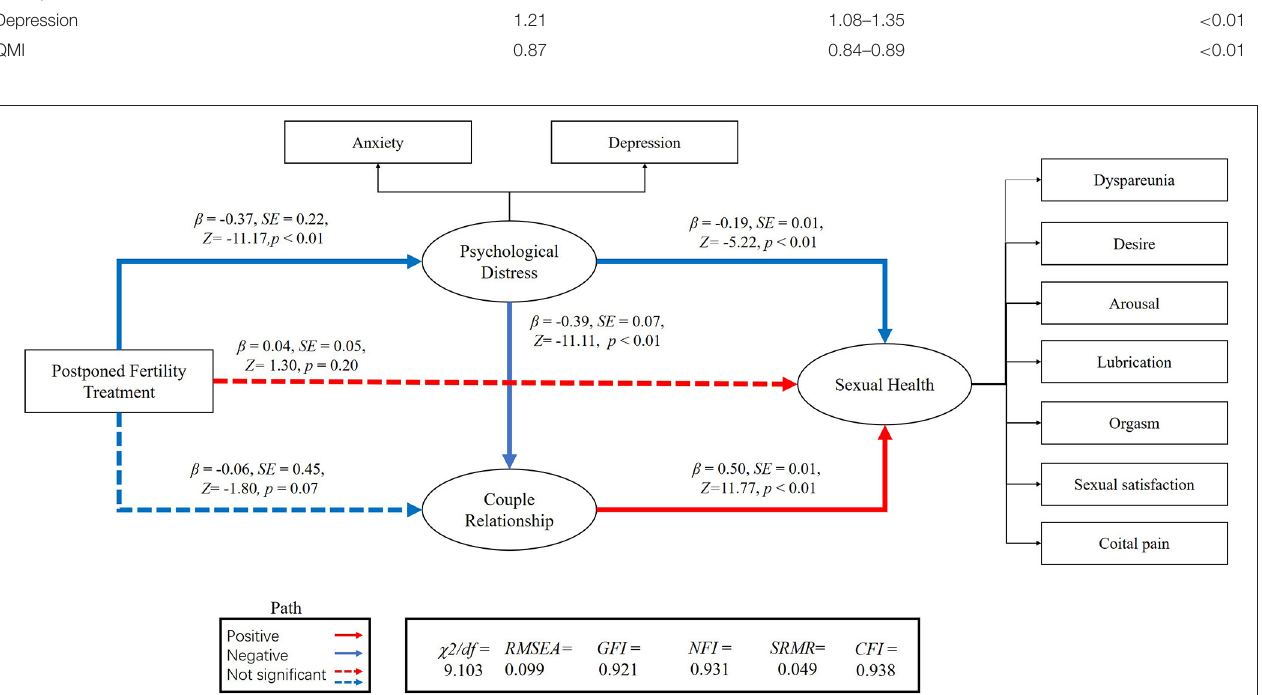
FIGURE 1 | Association between postponed fertility treatment and sexual health mediated by psychological distress and couple relationship quality in